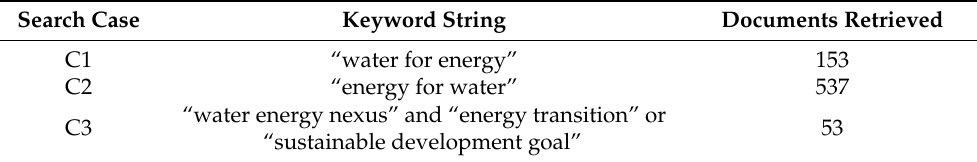
Table 1. Search cases, keyword strings and number of documents retrieved in Scopus database (5 January